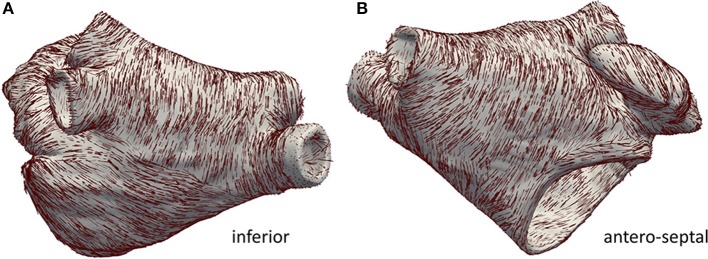
Anatomical model with annotated fiber bundles. In (A) the inferior wall is shown, in (B) the anterior/septal wall is shown.